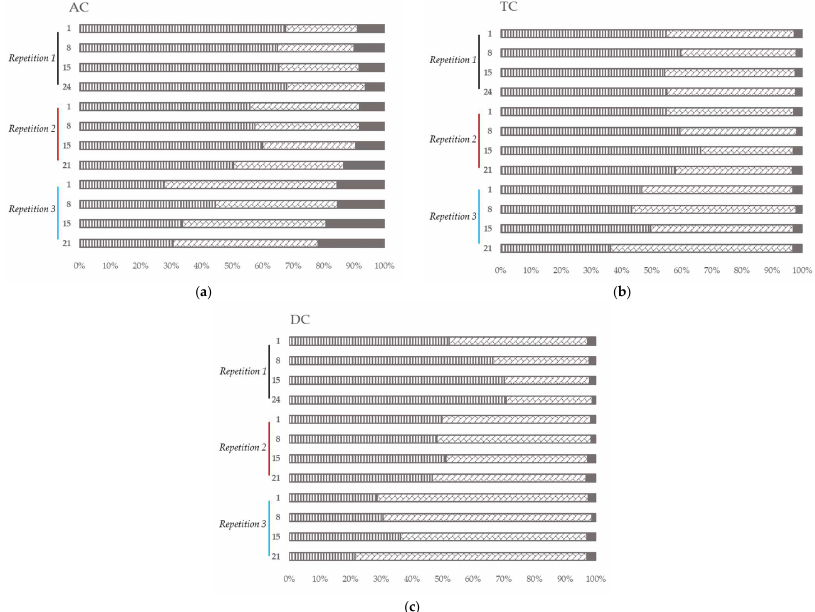
Figure 5. Microbial community analysis in ascending (AC) ( a ), transverse (TC) ( b ) and descending (DC) ( c ) colons assessed by 16S RNA Illumina Sequencing after one daily ULIP33 phage injection (10 mL at 10 9 PFU/mL) in the ascending colon for 7 days. Relative abundance histogram at phylum level (in %). Black line: repetition 1; burgundy line: repetition 2 and light blue line: repetition 3. Vertical stripes marks: Firmicutes phylum; diagonal bricks marks: Bacteroidota phylum; plain gray color: Proteobacteria phylum; plain black color: other phyla. In all colons, at genera level (Figure 6), Bacteroides and Lachnoclostridium covered more than 70% of the relative abundance in the first and second repetitions. In the third repetition, Lachnoclostridium was found in a lower proportion in all the colons (compared to the other repetitions) while Bacteroides showed a higher proportion mainly in DC. In AC (Figure 6a), Klebsiella and Phascolarctobacterium were found in high proportion in all the samples of the experiment. The abundance of Lachnospiraceae_ge was important in the first and second repetition. Tyzzerella was abundant in the first and third repetition while Escherichia-Shigella was abundant in the second and third. In TC (Figure 6b), Subdoligranulum was found in high proportion in the second and the third repetitions. Faecalibacterium and Lachnospiraceae_ge were abundant in all the sam- ples of all repetitions and Phascolarctobacterium in the first repetition. In DC (Figure 6c), the main genus found were Phascolarctobacterium (all repetitions), Lachnospiraceae_ge ( all repetitions), Faecalibacterium (repetition 1), and Subdoligranulum (repetitions 2 and 3).